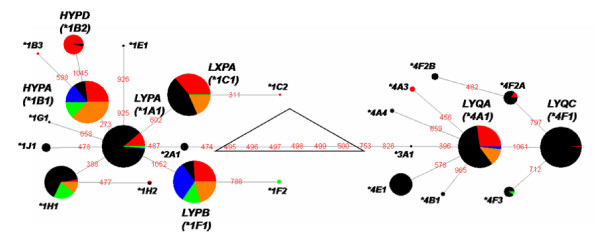
Mutational network of MBL2 haplotypes. The size of each node is proportional to the haplotype frequency in the pooled sample (this work and [18,28]). Variant nucleotide positions are indicated in red. In black: African; red: European; orange: North Chinese; blue: Guarani; green: Kaingang.